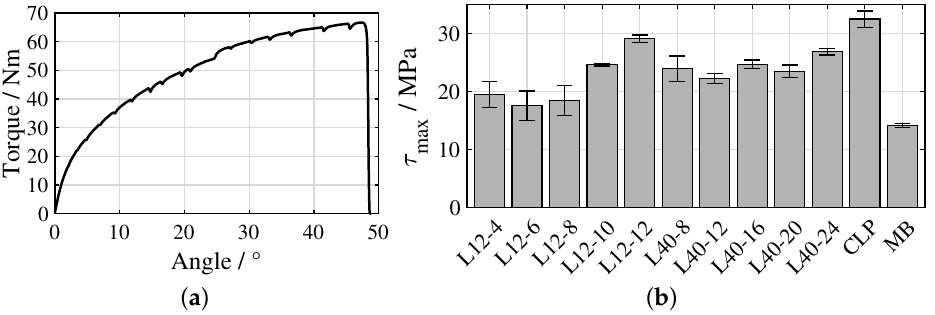
Figure 8. Results of the hollow cylinder torsion tests: ( a ) exemplary angle/torque curve of the L12-12 structure, ( b ) τ max of all investigated structures; mean values ± 1SD.